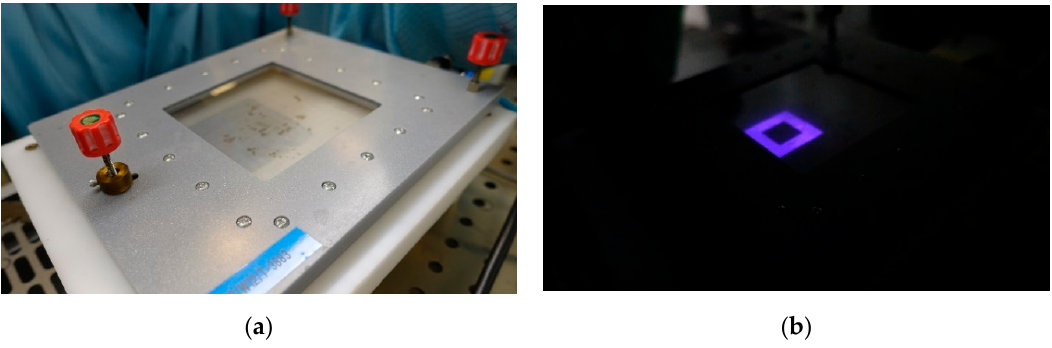
Figure 3. A view of the reactor for selective plasma modification: ( a ) before and ( b ) after plasma ignition. The window allows for observation of the discharge fidelity.